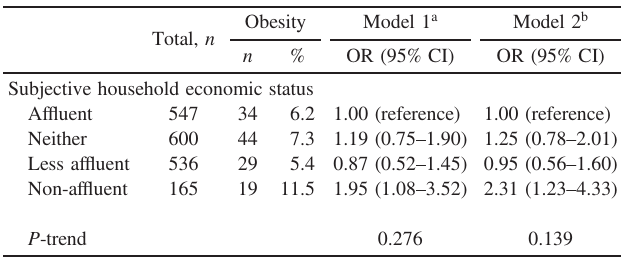
CI, con fi dence interval; OR, odds ratio. a Model 1 was adjusted for gender and age (month; continuous). b Model 2 was adjusted for gender, age (month; continuous), health literacy score (tertile categories: ≤ 18 points, 19 – 20 points, ≥ 21 points,